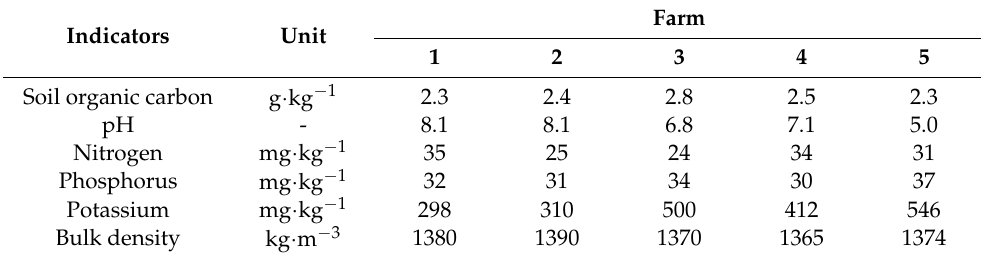
Figure 2. Districts of the Kherson province. Table 1. Primary soil properties.